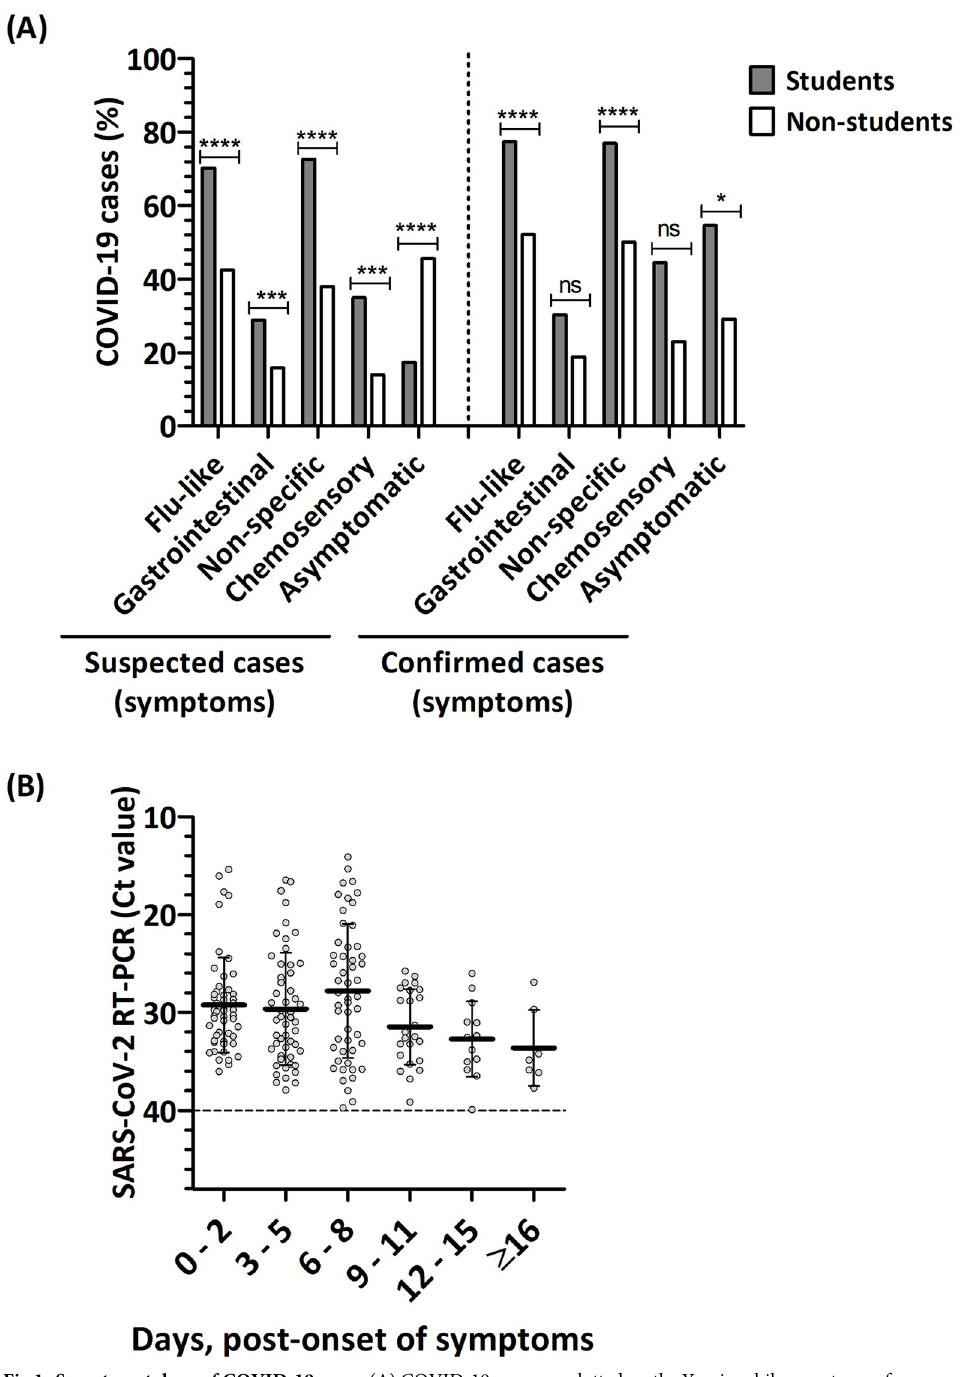
Fig 1. Symptomatology of COVID-19 cases. (A) COVID-19 cases are plotted on the Y-axis, while symptoms of suspected and confirmed cases are plotted on the x-axis. Bars represent percentages of students (grey) and non-students (white). Figure shows χ 2 tests between student and non-student groups of suspected COVID-19 cases (n = 705): flu-like ( χ 2 = 85.566, df = 1, p = 0.0000), gastrointestinal ( χ 2 = 7.487, df = 1, p = 0.006), non-specific ( χ 2 = 84.532, df = 1, p = 0.000), chemosensory symptoms ( χ 2 = 8.438, df = 1, p = 0.004) and asymptomatic ( χ 2 = 12.489, df = 1, p = 0.000) (ns = not significant, ��� p < 0.001, ���� p < 0.0001). Figure also shows χ 2 test between student and non-student groups of confirmed COVID-19 cases (n = 372): flu-like symptoms ( χ 2 = 12.906, df = 1, p = 0.0000), gastrointestinal disorders ( χ 2 = 1.368, df = 1, p = 0.242), non-specific ( χ 2 = 12.344, df = 1, p = 0.0000), chemosensory symptoms ( χ 2 = 2.647, df = 1, p = 0.104), and asymptomatic ( χ 2 = 4.399, df = 1, p = 0.036) (ns = non-significant, � p < 0.05, ���� p < 0.0001). (B) The